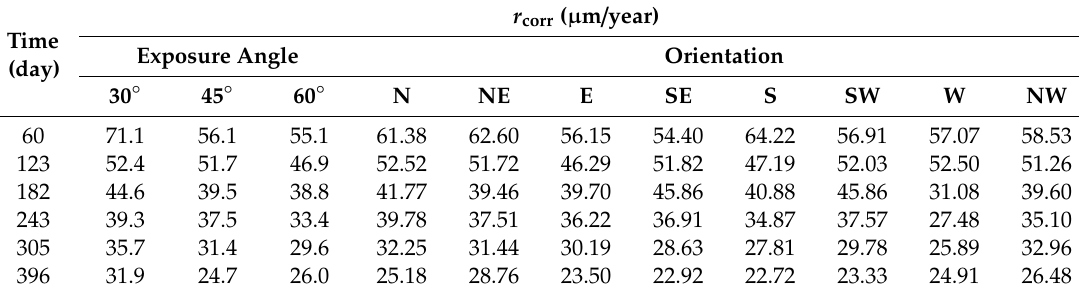
Table 4. Variation of the corrosion rates measured with di ff erent exposure angles and orientations of the carbon steel panels. N (north), NE (northeast), E (east), SE (southeast), S (south), SW (southwest), W (west), NW